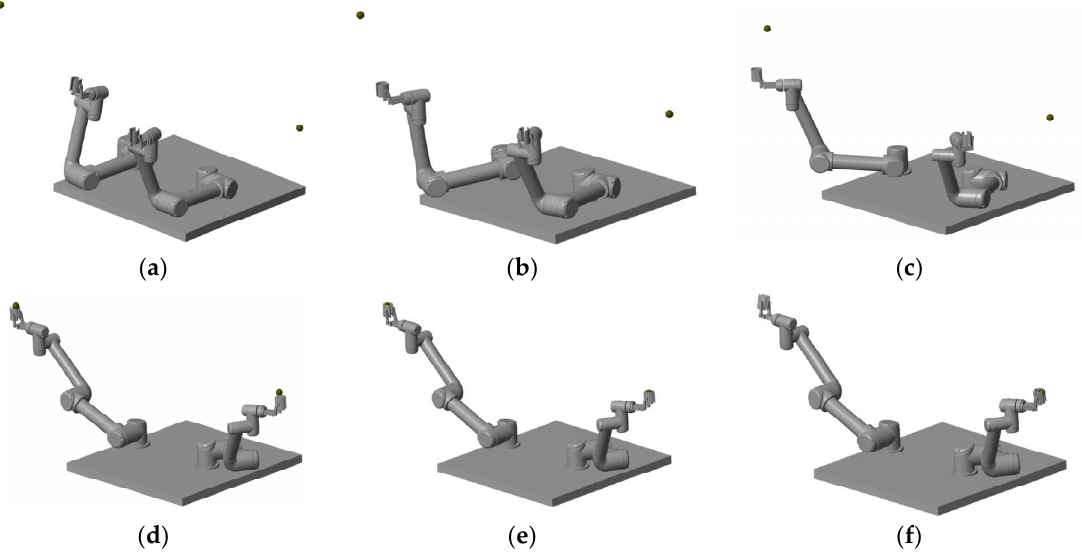
Figure 15. The motion simulation process of the pickable area with the double-arm. ( a ) Initial position. ( b ) Collision detection. ( c ) Dual robotic arm planning path. ( d ) Locating the fruit. ( e ) Grabbing the fruit. ( f ) Separating the fruit.